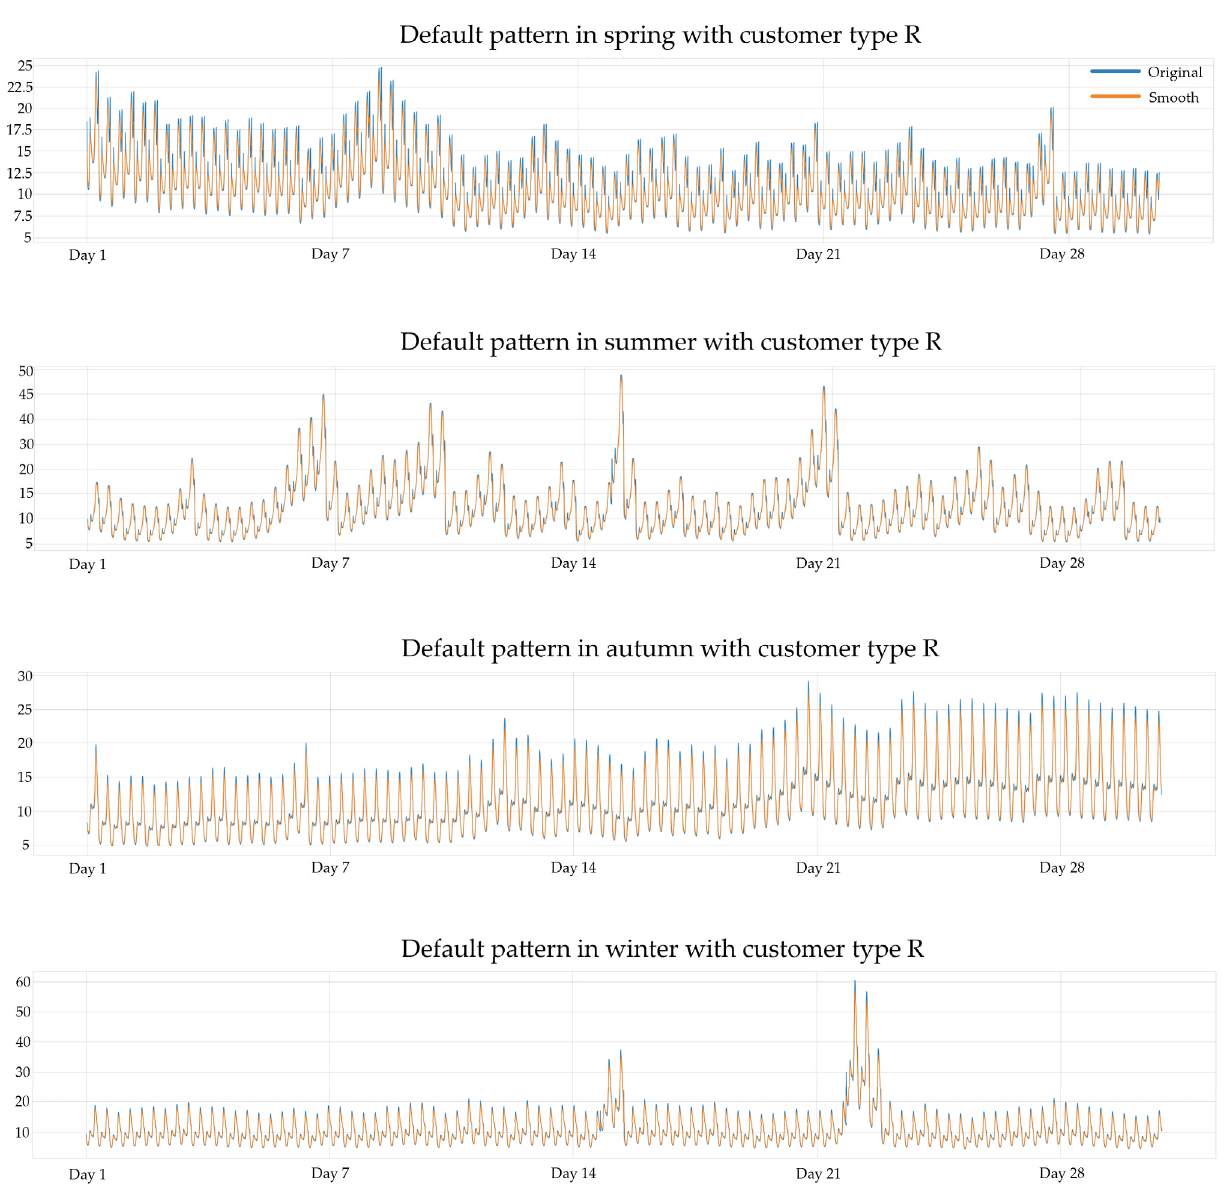
Figure 7. Sample reconstructed SA1 level demand pattern for residential users in four seasons (kWh).